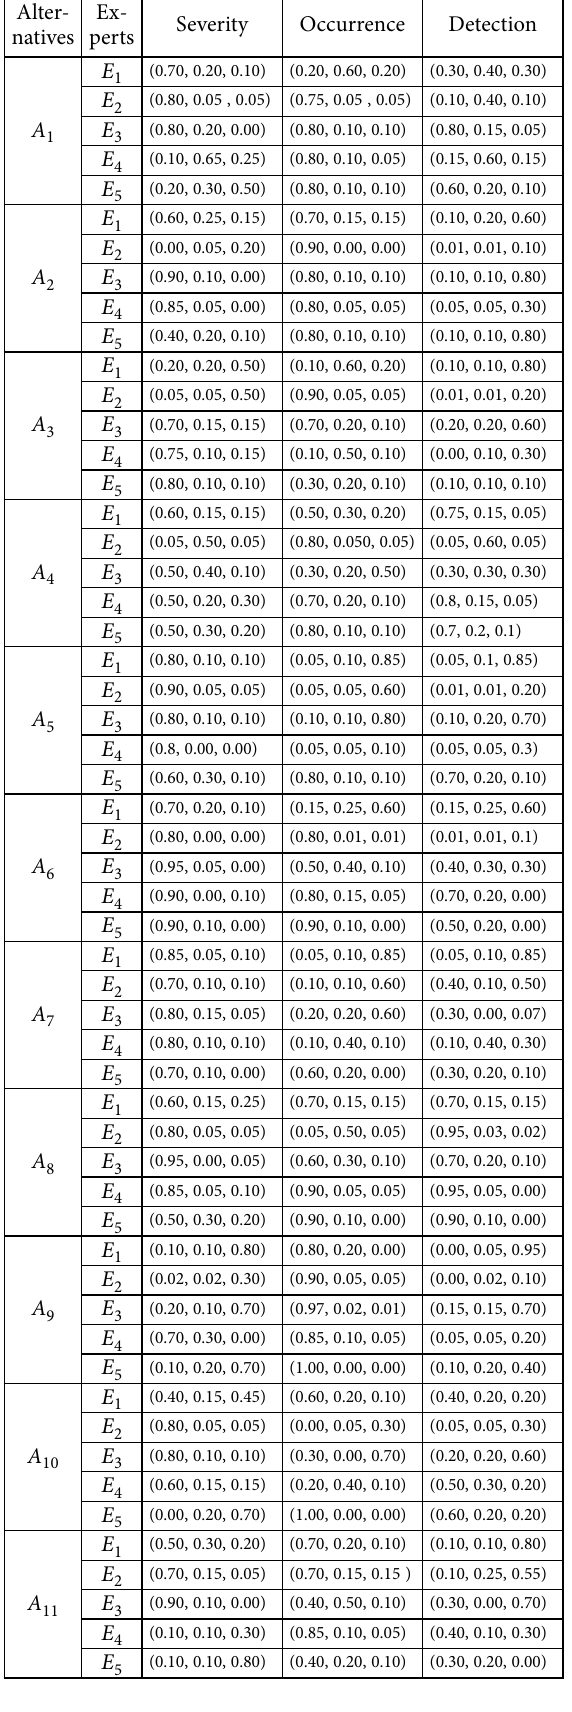
Table 2. FBS individual decision matrices Alter- Ex- Severity natives perts